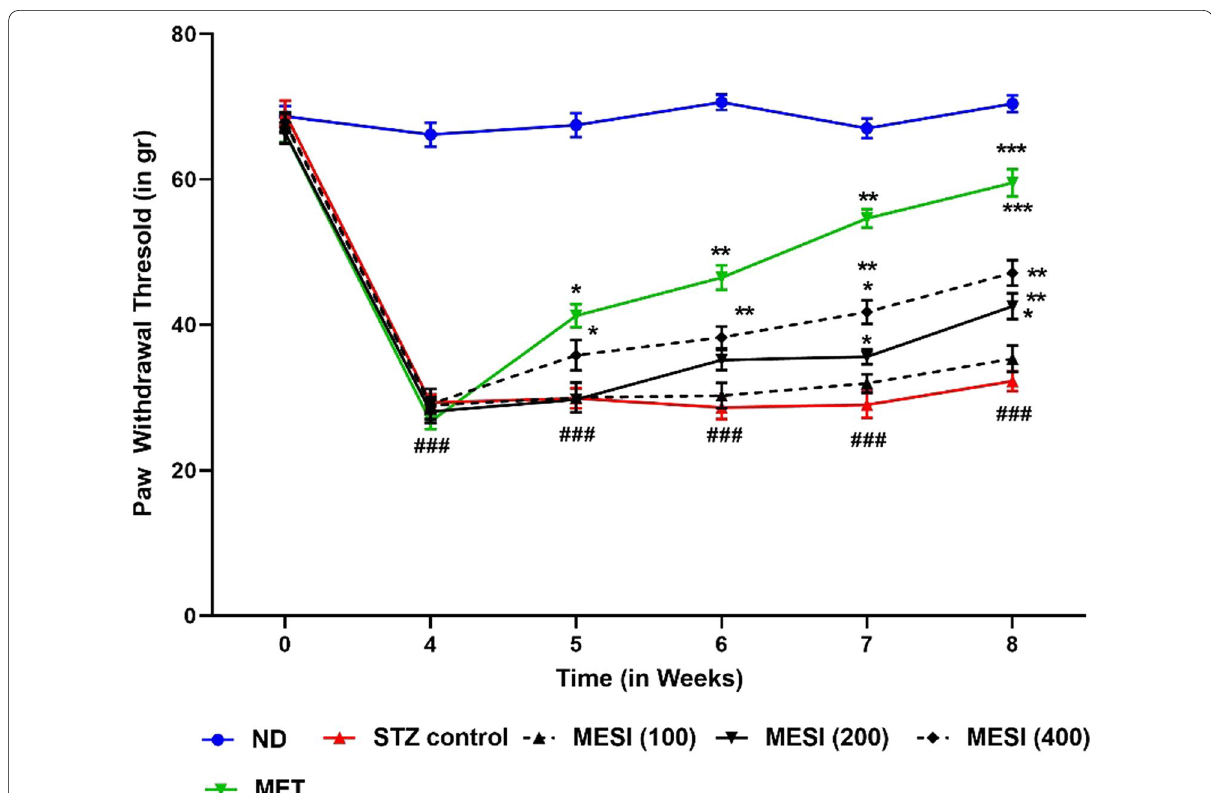
Fig. 2 Effect of chronic treatment of MESI and metformin on mechanical allodynia in von Frey hair test. Data are expressed as mean and analyzed by two-way ANOVA followed by Bonferroni’s multiple range post hoc test. *P < 0.05 and **P < 0.01for MESI, and *** P < 0.001 for metformin-treated groups compared to the diabetic (STZ) control group. ### P < 0.001 for the diabetic (STZ) control group compared to the normal non-diabetic